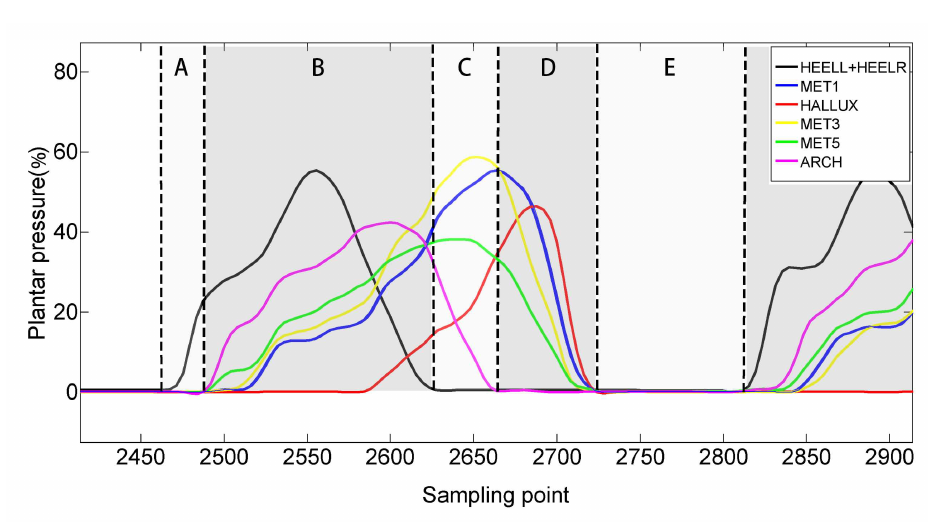
Figure 5. Gait phase classified by plantar pressure data. This picture shows how the pressure data of one cycle can be divided into five gaits. The starting point of the black line represents the touch of the ground by the heel; the starting point of the purple line represents the full touch of the right foot (left toe off the ground); the end of the black line represents the right heel off the ground (the left and right feet are exchanged); the end of the purple line represents the right arch of the foot is off the ground (the left heel touches the ground); the end of the red line represents the right toe off the